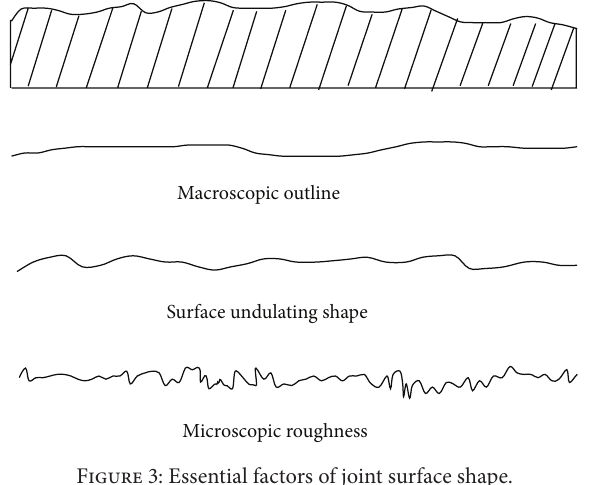
Figure 3: Essential factors of joint surface